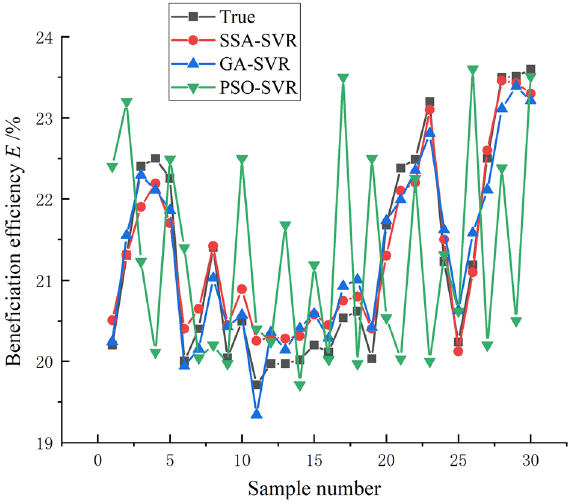
Figure 8. Simulation results of the models on beneficiation efficiency E of shaking table.